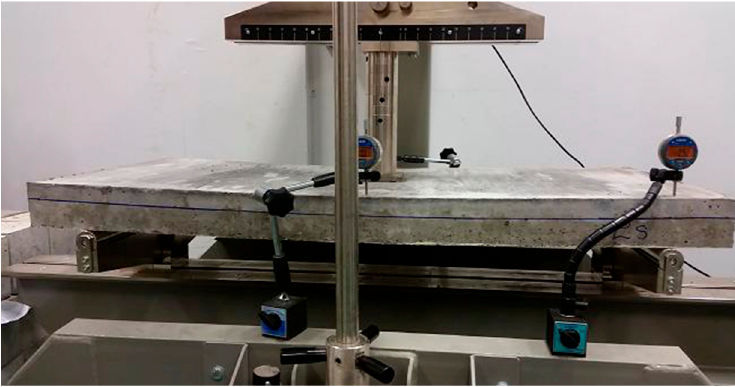
Figure 5. Bending resistance test of a concrete slab—specimen sample subjected to a local axial force.